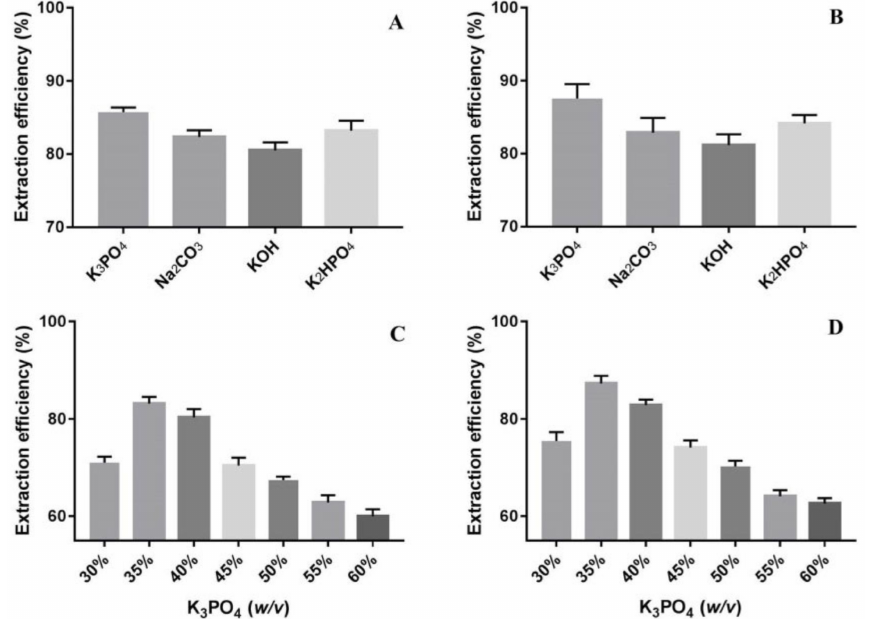
Figure 1. Comparison of protein extraction efficiency using different inorganic salts ( A ), different inorganic salts with pH values adjusted to 9.0 ( B ), different concentrations of K 3 PO 4 with the following experimental condition: 1.0 g IL, 10 mg BSA and 5.0 mL ddH 2 O under room